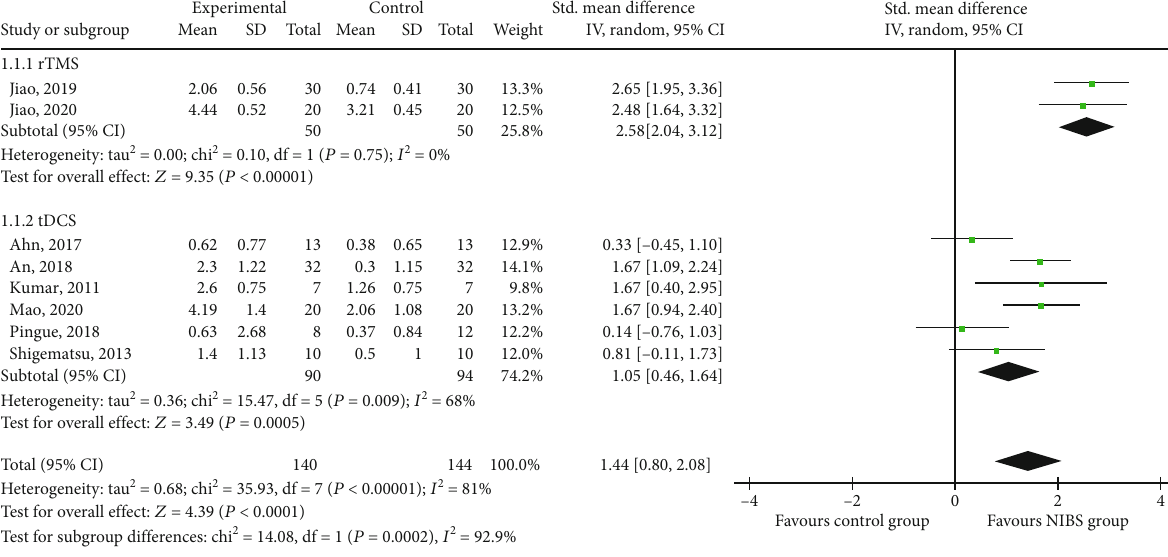
Figure 3: E ff ects of NIBS on DOSS scores of patients with dysphagia after stroke.